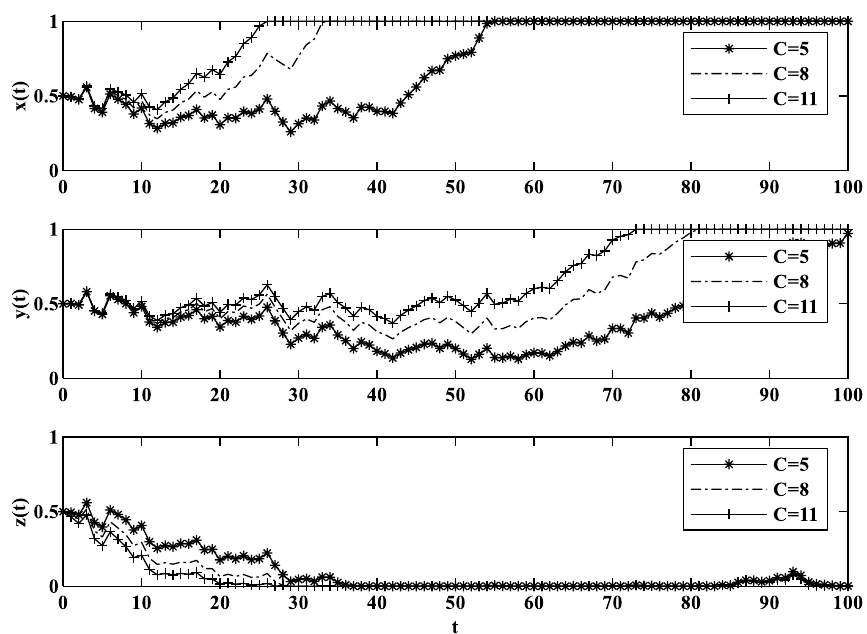
Fig. 13 Impact of SD’s cost on evolutionary process under scenario